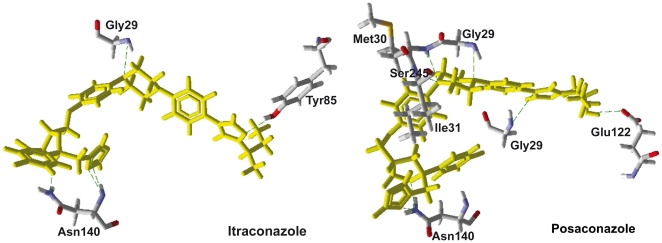
H-bonds (in green) observed for Itraconazole and Posaconazole (in yellow) with the active site residues of PfLDH.